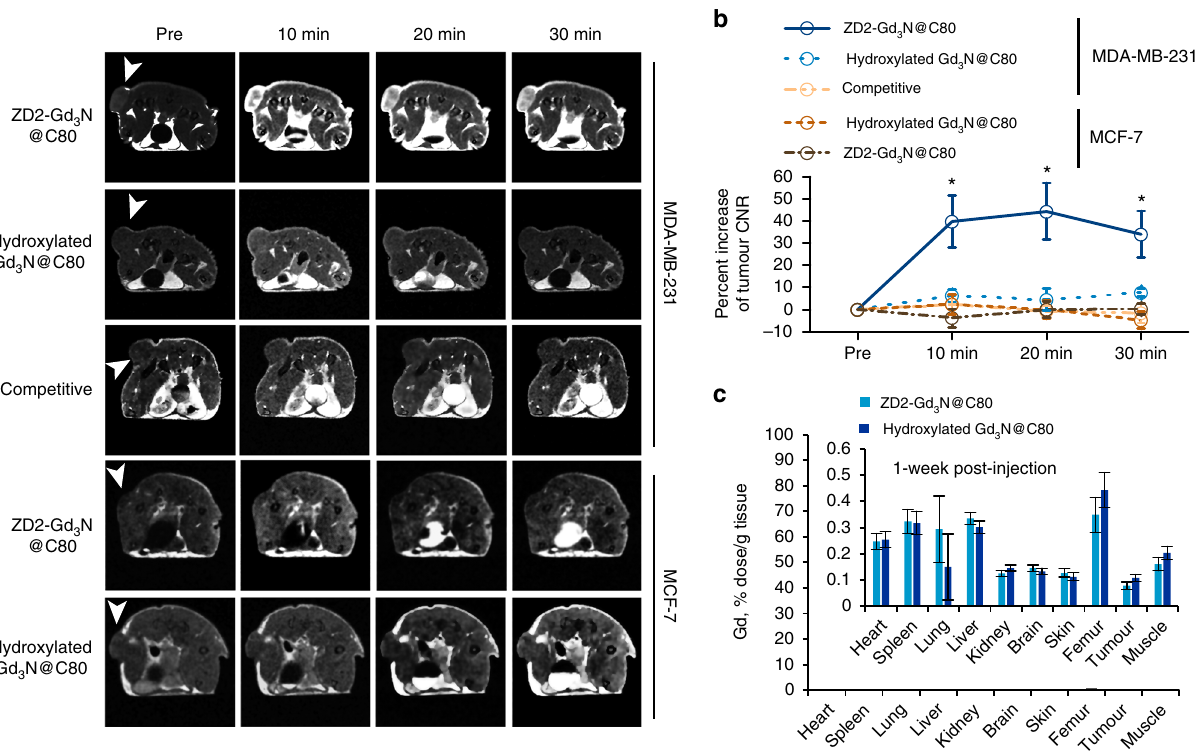
Fig. 4 Contrast enhanced MRI with ZD2-Gd 3 N@C80 of MDA-MB-231 and MCF-7 tumours in mice. a Representative axial T 1 -weighted 2D spin-echo MRI images of MDA-MB-231 and MCF-7 tumours in mice. Images were acquired before and at 10, 20 and 30 min after injection of ZD2-Gd 3 N@C80 and hydroxylated Gd 3 N@C80 at a dose of 1.67 µ mol, or a mixture of 25 µ mol kg − 1 free ZD2 and 1.67 µ mol ZD2-Gd 3 N@C80 (competitive group). Tumour locations are indicated by white arrow heads . b Analysis of percentage increase of tumour contrast-to-noise ratio ( CNR ) from images acquired in groups indicated in ( a ) (data are presented as mean ± s.e.m. n = 4 for MDA-MB-231 tumours and n = 3 for MCF-7 tumours. * P < 0.05 for comparison of the increased CNR ratio of ZD2-Gd 3 N@C80 in MDA-MB-231 group with that in all the other groups). c Gd biodistribution at 1 week after injection of ZD2-Gd 3 N@C80 or hydroxylated Gd 3 N@C80 in MDA-MB-231 tumour models. There was no statistical difference between retention of the contrast agents in all the tested tissues (data are presented as mean ± s.e.m. n =